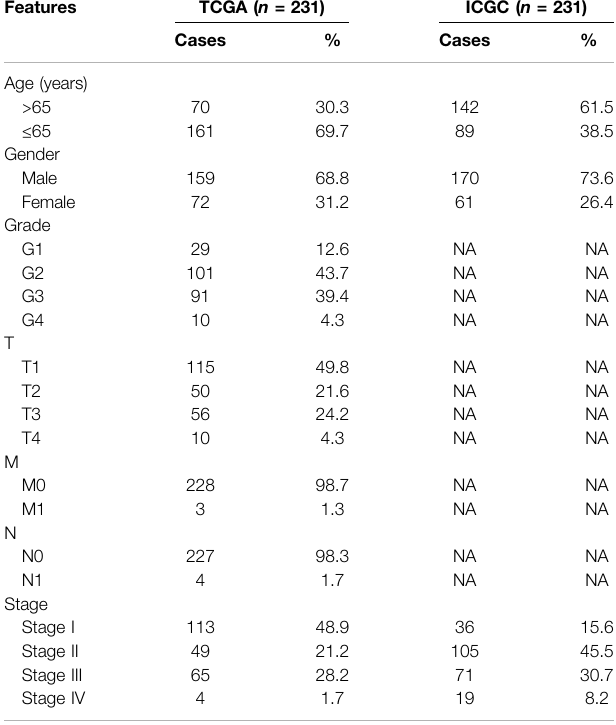
TABLE 1 | Clinical features of the LIHC